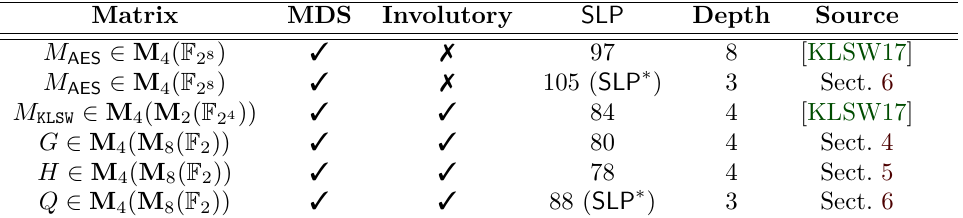
Table 1: A summary of the results. All matrices shown in the table are 32 × 32 binary matrices, and M k ( R ) is the set of all k × k matrices whose entries are drawn from R . The SLP column is obtained by applying Boyar’s SLP heuristic [BMP13], and SLP ∗ means that the result is obtained by applying a modified version of Boyar’s SLP heuristic with circuit depth awareness presented in Sect.